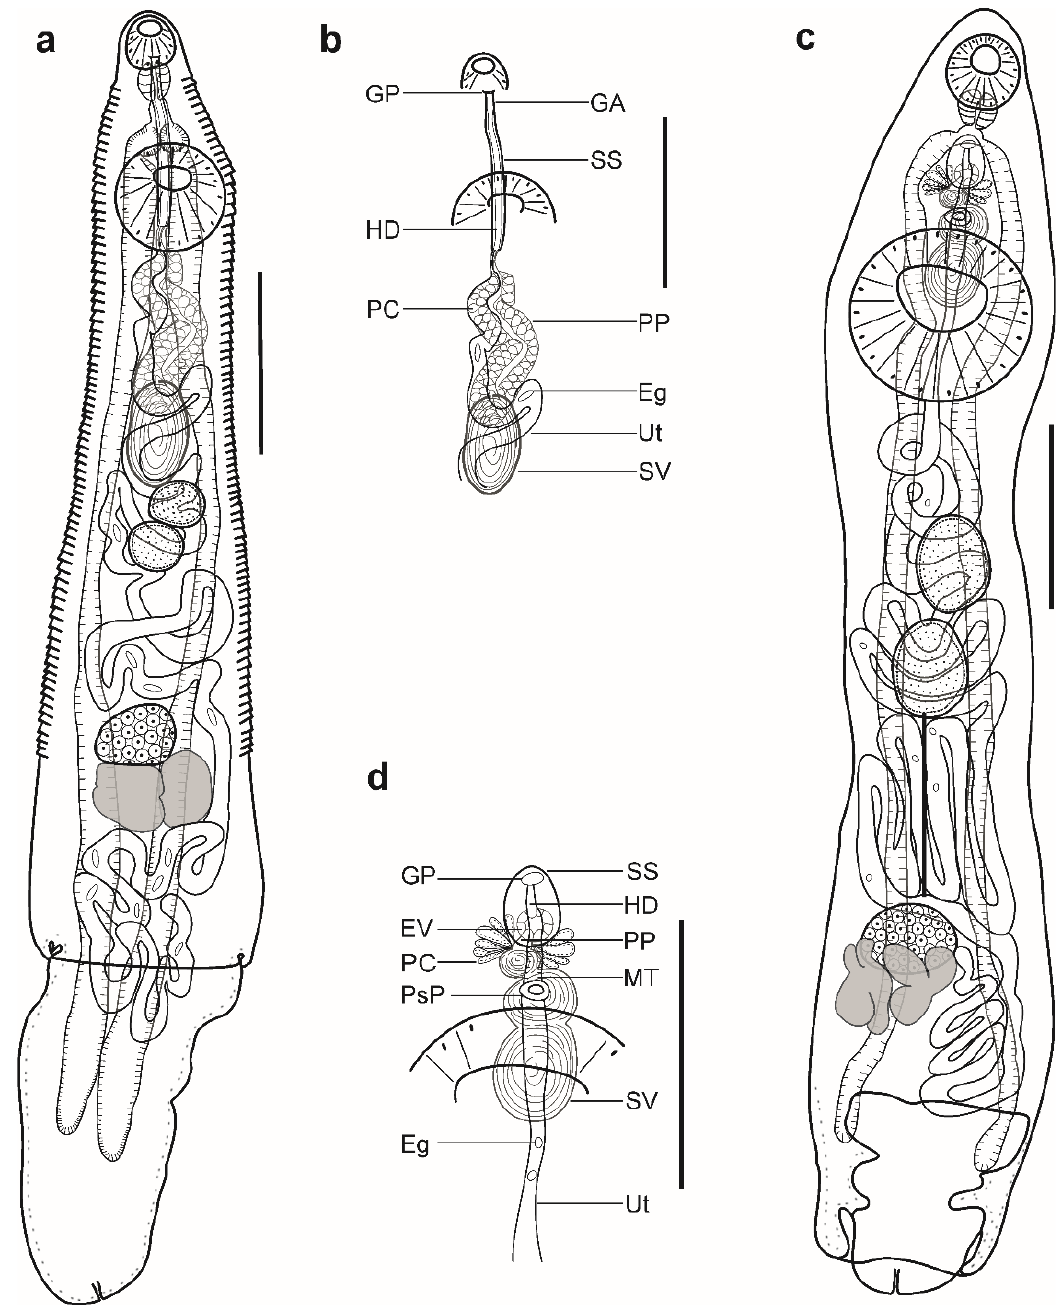
Figure 2. Hemiurid parasites of marine fishes from Brazil. ( a , b ) Adult of Parahemiurus merus ex Harengula clupeola : ( a ) complete specimen, ventral view; ( b ) detail of the terminal genitalia, ventral view. ( c , d ) Adult of Lecithochirium microstomum ex Trichiurus lepturus : c complete specimen, ventral view; ( d ) detail of the terminal genitalia, ventral view. Scale bars ( a , b ): 400 µ m, ( c , d ): 500 µ m. Abbreviations : Eg, eggs; EV, ejaculatory vesicle; GA, genital atrium; GP, genital pore; HD, hermaphroditic duct; PC, prostatic cells; PP, pars prostatica; SS, sinus-sac; SV, seminal vesicle; Ut, uterus.